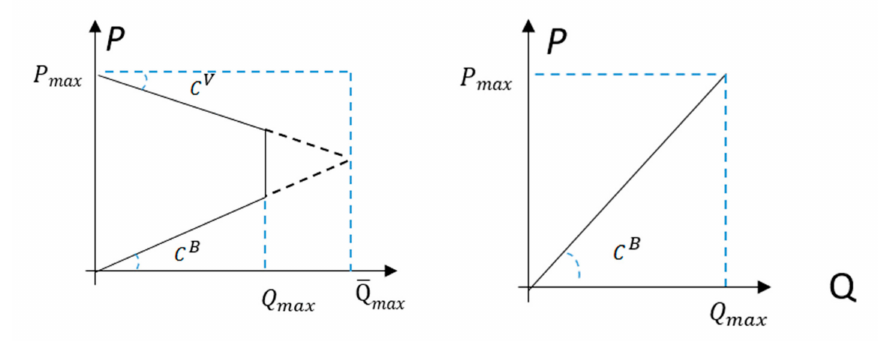
Figure 2. Simplified Power-Heat diagram for backpressure ( right ) and extraction ( left ) units